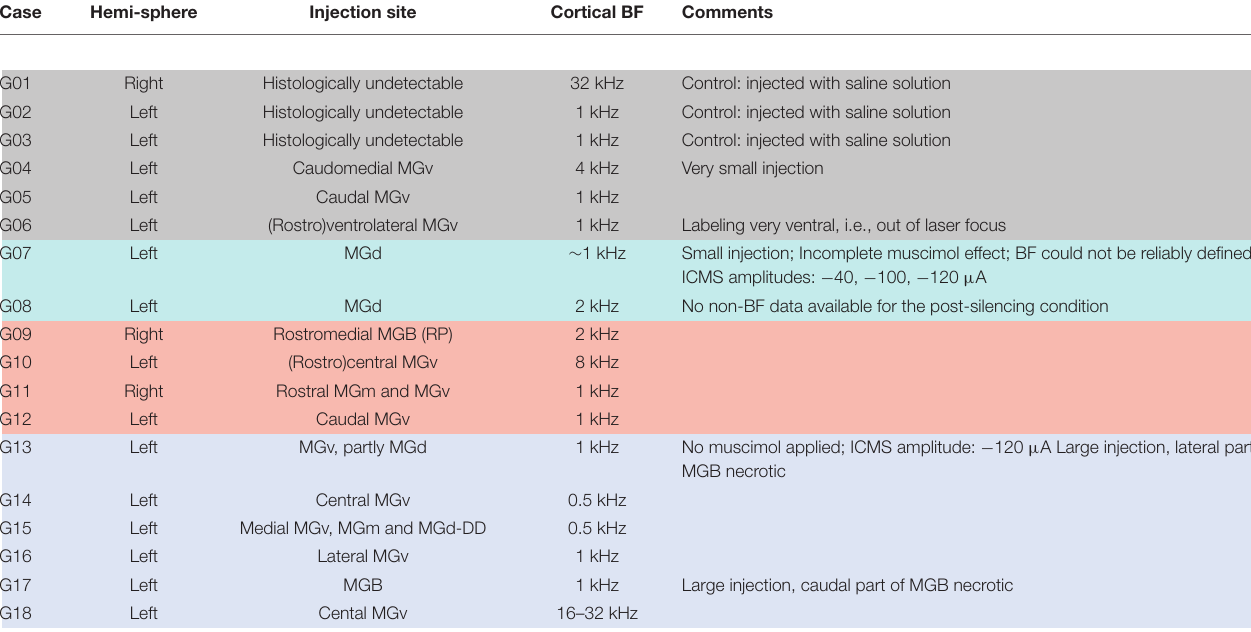
TABLE 1 | Experimental animals used for CSD analysis a .